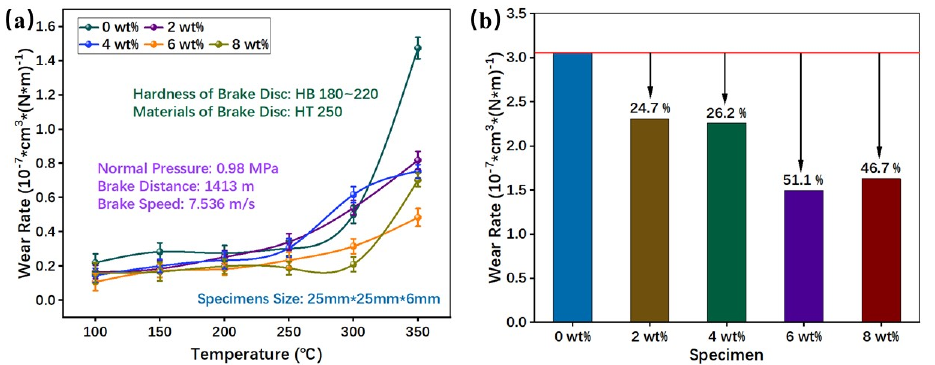
Figure 10. Wear rate of each specimen; ( a ) Wear rate at each temperature, ( b ) Total Wear